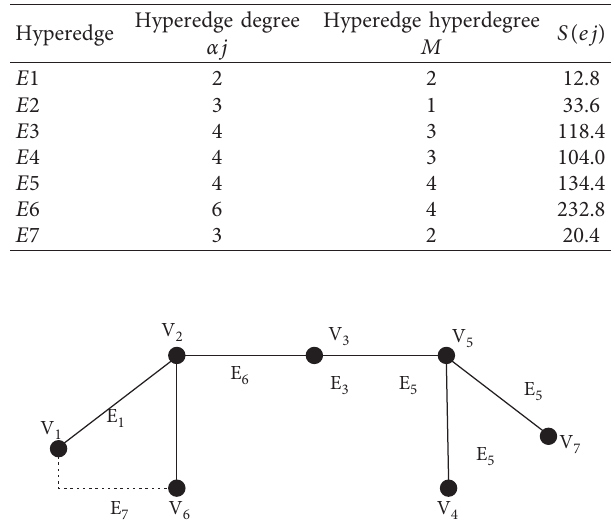
Table 3: Analysis of influence degree of uncertain events.